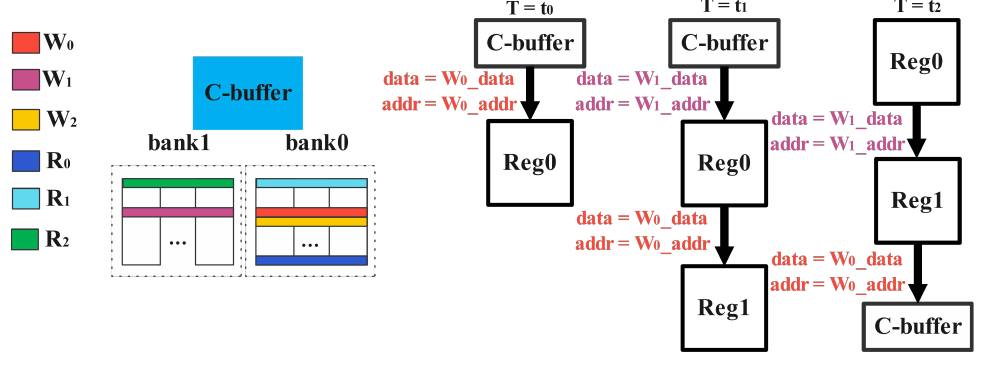
Figure 8. The special conflict of memory